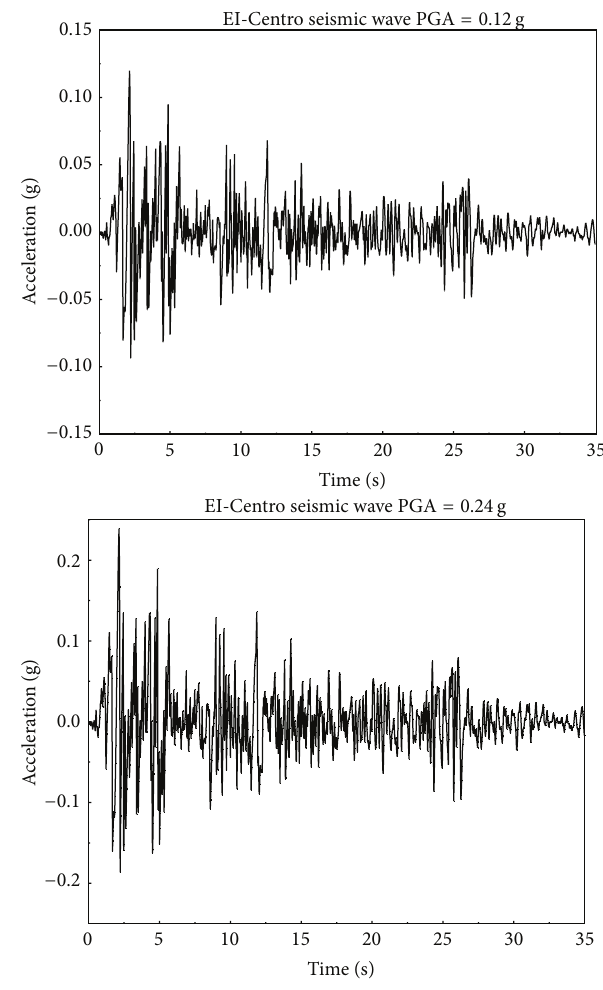
Figure 2: Time-history curves of ground motion acceleration for two different seismic wave amplitudes.